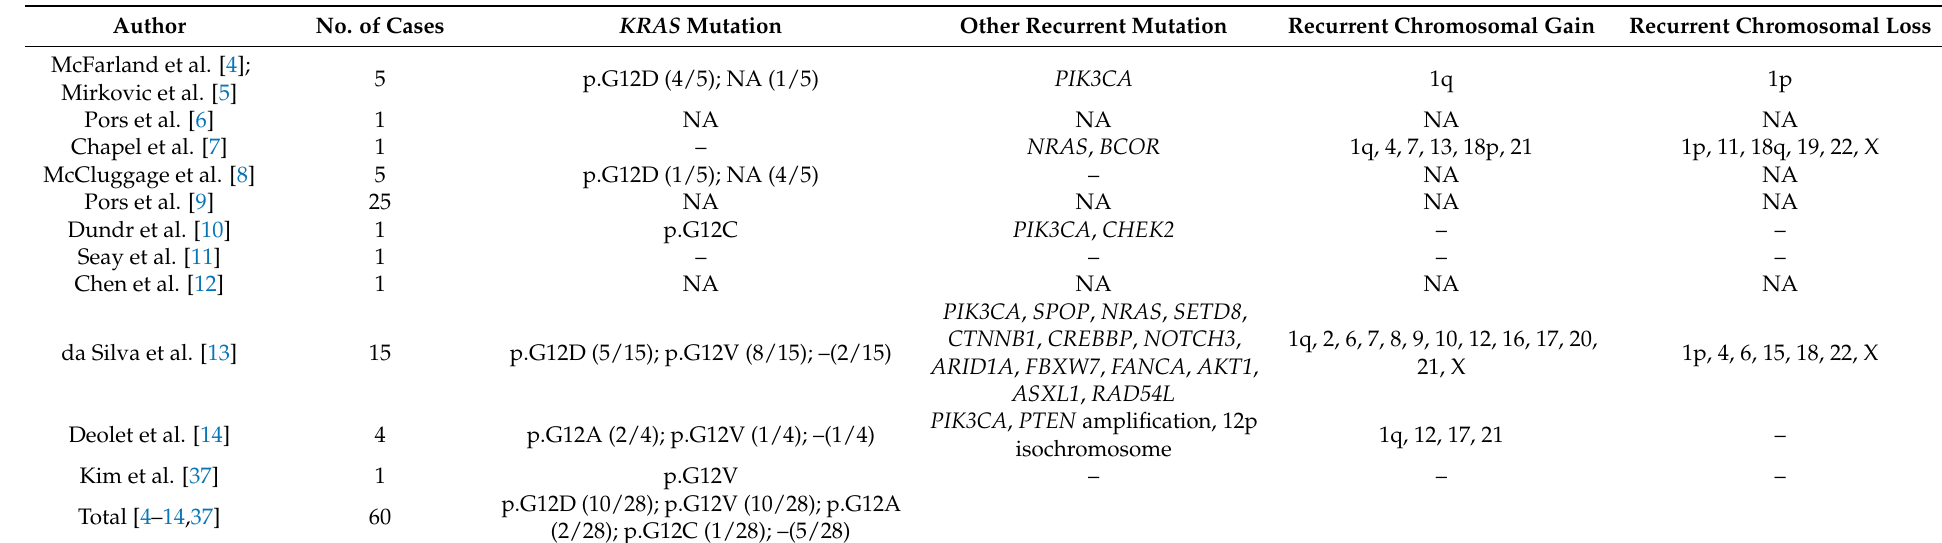
Table 7. Genetic features of previously published cases of ovarian mesonephric-like